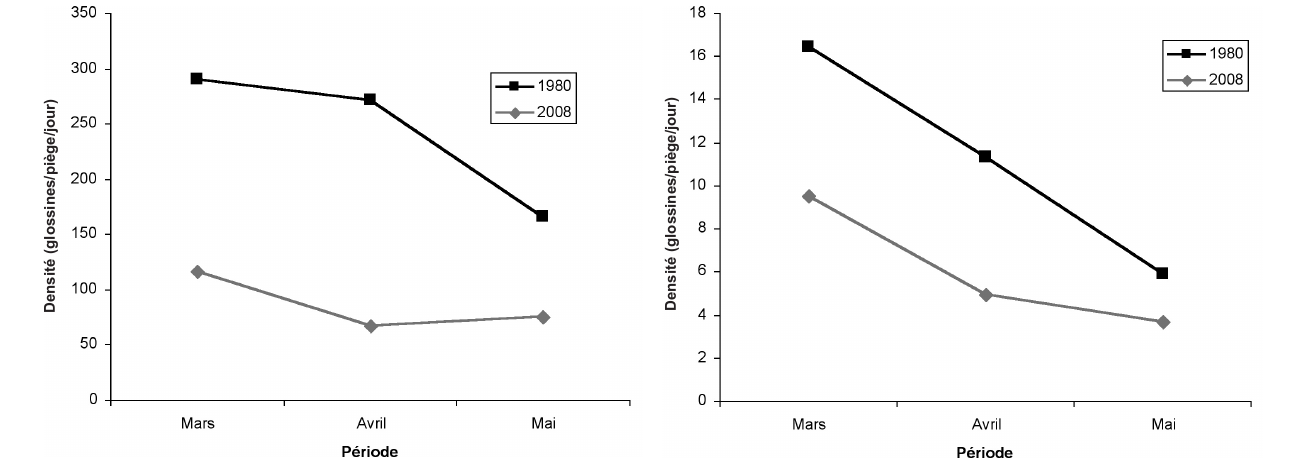
Fig. 6. – Comparaison dans le temps des densités de Glossina pal- palis gambiensis